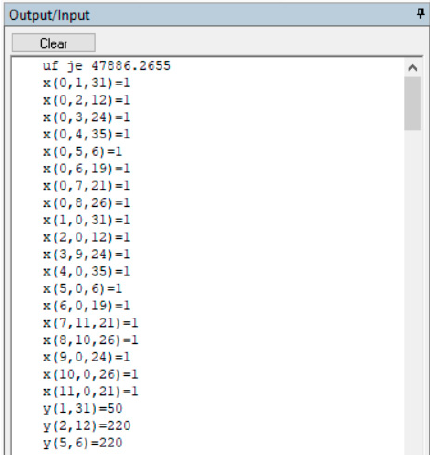
Figure 4. Results in Xpress-IVE software.